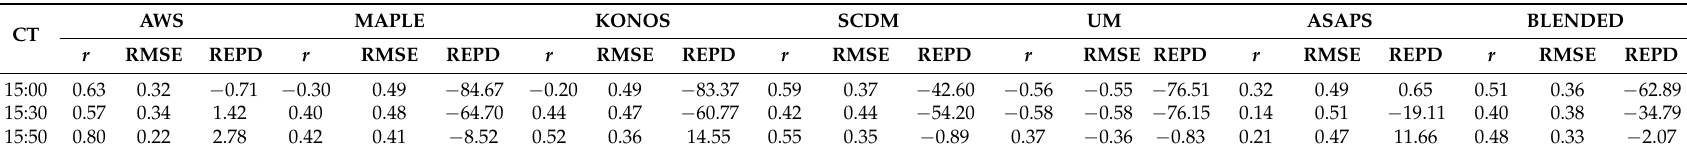
Table 1. Evaluation results for simulated water depth using various QPF products (Case 1) in terms of correlation coefficient ( r ), relative error of peak depth (REPD), and root mean square error (RMSE) by current time (CT).